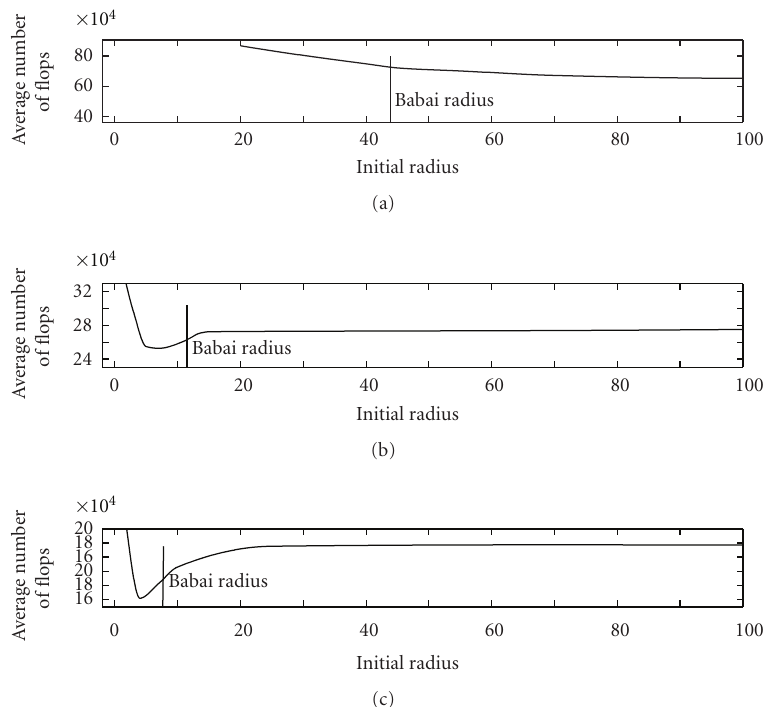
Figure 3: The average number of flops versus initial radius of SE-SD algorithm when P = 4, M = 64. (a) σ 2 = 2 . 49 ( ρ = 7 . 5dB), (b) σ 2 = 1 . 02 ( ρ = 11 . 4dB), (c) σ 2 = 0 . 65 ( ρ = 13 .